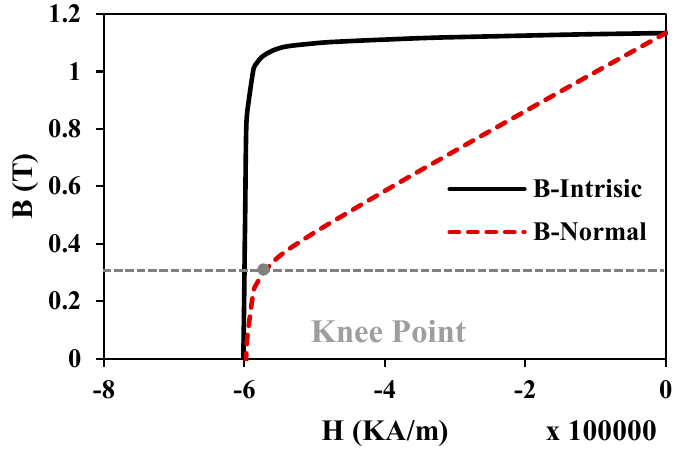
Figure 23. B-H curve for N35 under 80 °C.